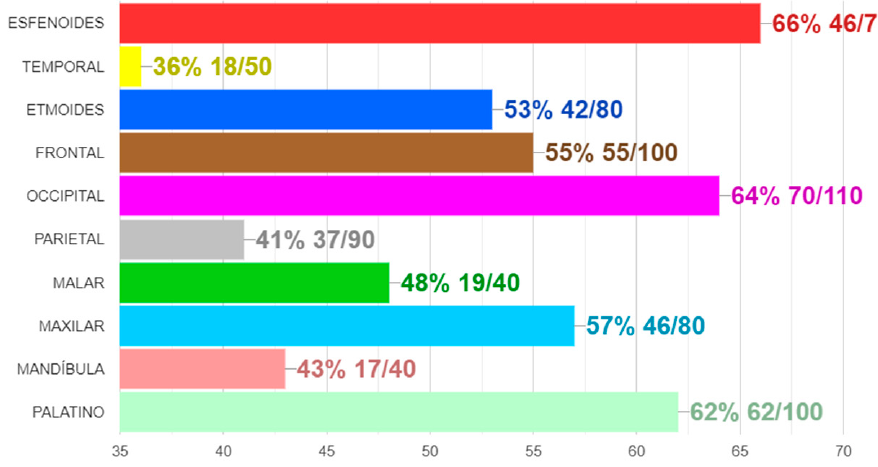
Figure 4. Score and Success Rate of A Test by Team.